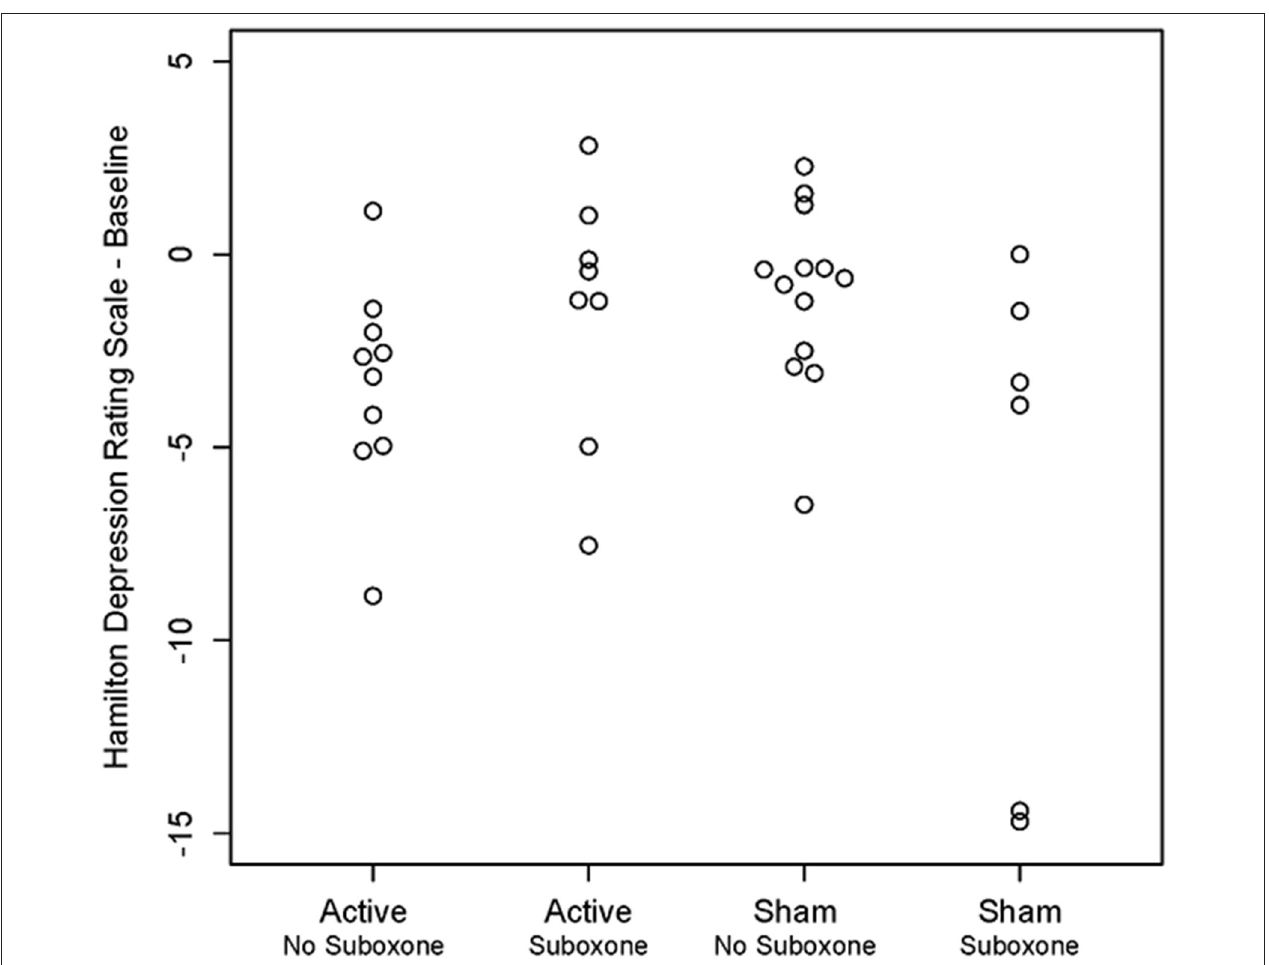
FIGURE 6 | Scatter plot showing individual results for participants on and not on medication management with buprenorphine/suboxone following active vs. sham treatment with unilateral transcranial photobiomodulation. Note unexpected reduction in Hamilton Depression Rating Scale scores in two participants on buprenorphine who received sham